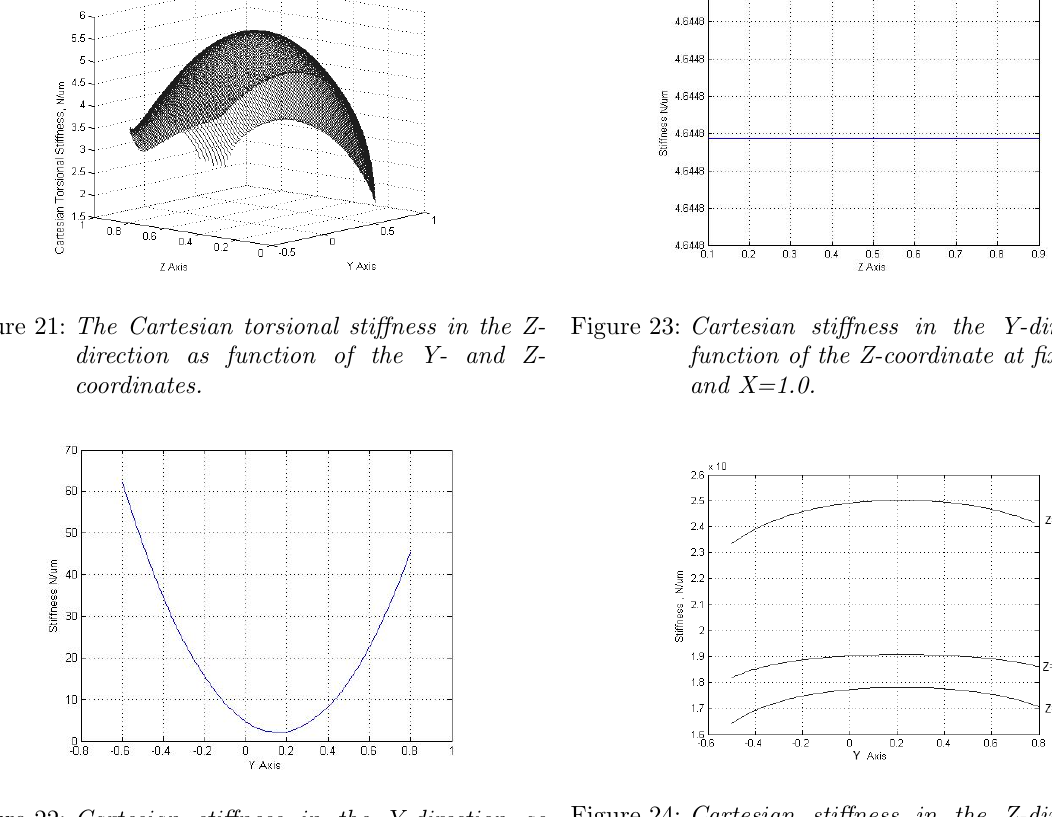
Figure 22: Cartesian stiffness in the Y-direction as function of the Y-coordinate at fixed X=1.0 and Z=0.4.